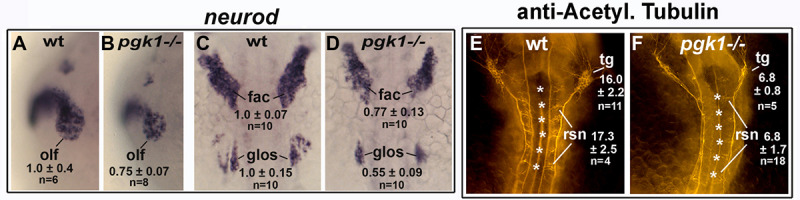
Deficiencies in Fgf-dependent cell types in pgk1- / - mutants.(A–D) Expression of neurod at 24 hpf showing lateral views of the olfactory epithelium (olf) (A, B) and dorsal views of the facial (fac) and glossopharyngeal (glos) ganglia (C, D) in wild-type and pgk1- / - embryos. Numbers indicate relative surface area of each expression domain (normalized to wild-type controls)± standard deviation and number of specimens. Expression domains are significantly smaller in pgk1- / - mutants (p<0.0001). (E, F) Dorsal view (anterior to the top) of anti-acetylated tubulin staining in the hindbrain region in a wild-type embryo (E) and pgk1- / - mutant (F). Positions of reticulospinal neurons (rsn) and trigeminal ganglia (tg) are indicated. Numbers indicate the mean number of neurons per side ± standard deviation and number of specimens. The number of neurons is significantly reduced in pgk1- / - mutants (p<0.0001).